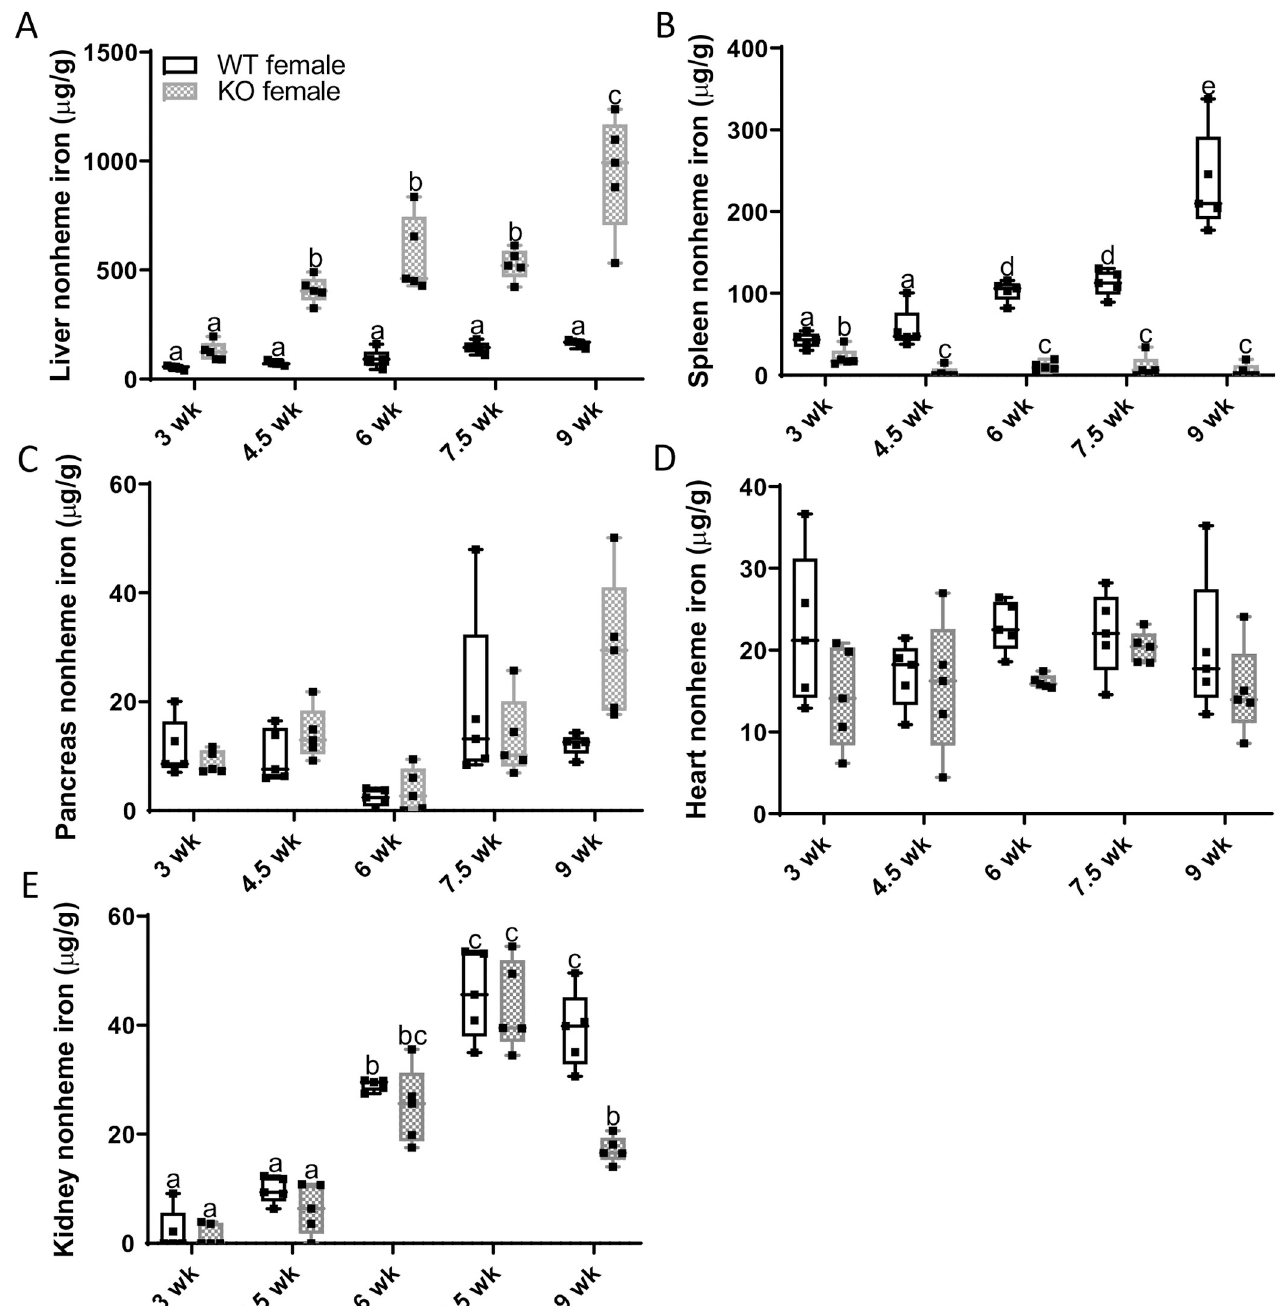
Fig 6. Hepatic iron loading and splenic iron depletion begins soon after weaning in female Hamp KO rats. To determine the age of initial iron loading, tissue nonheme iron levels were quantified in female Hamp -/- rats and WT littermates at various ages after weaning. Shown are nonheme iron levels in the liver ( A ), spleen ( B ), pancreas, ( C ), heart ( D ) and kidney ( E ). Data are presented as box plots for n = 4–5 rats/group and were analyzed by 2-way ANOVA followed by Tukey’s multiple comparisons test. Some data were first log-transformed due to unequal variance ( C-E ); however, untransformed data are presented for ease of interpretation. Groups labeled with different letters vary significantly (p < 0.041; A, B, E ). Genotype × Age, p � 0.0003 ( A, B, E) ; Genotype, p � 0.0093 (A, B, D, E); Age, p � 0.008( A-C, E